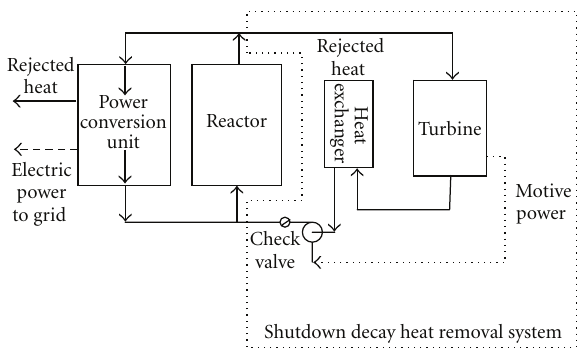
Figure 14: Direct-cycle layout with an autonomous shutdown decay heat removal